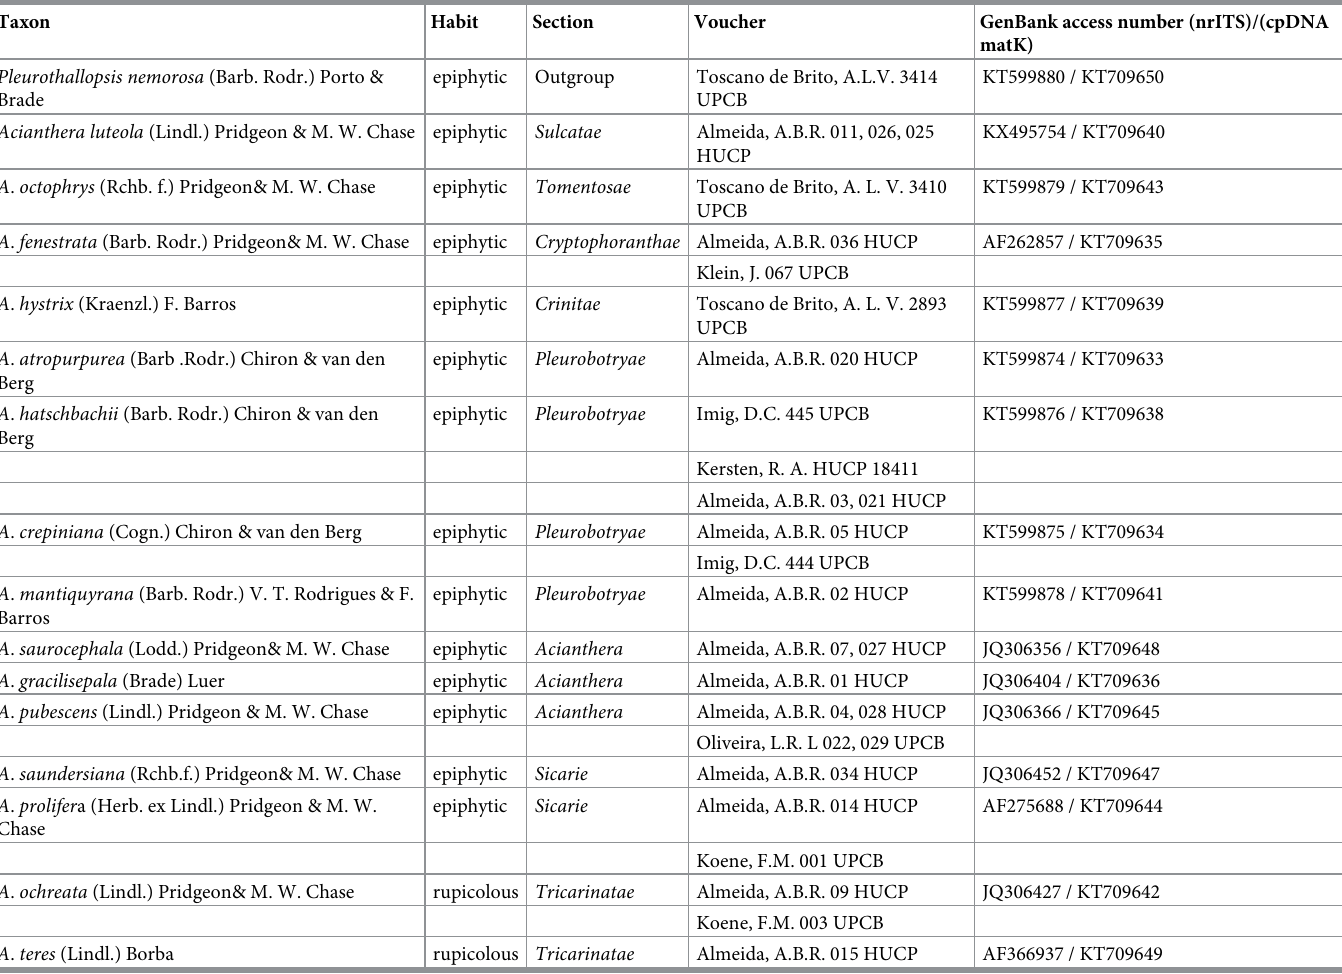
Table 1. Acianthera specimens used for analysis of the vegetative organs anatomy and floral